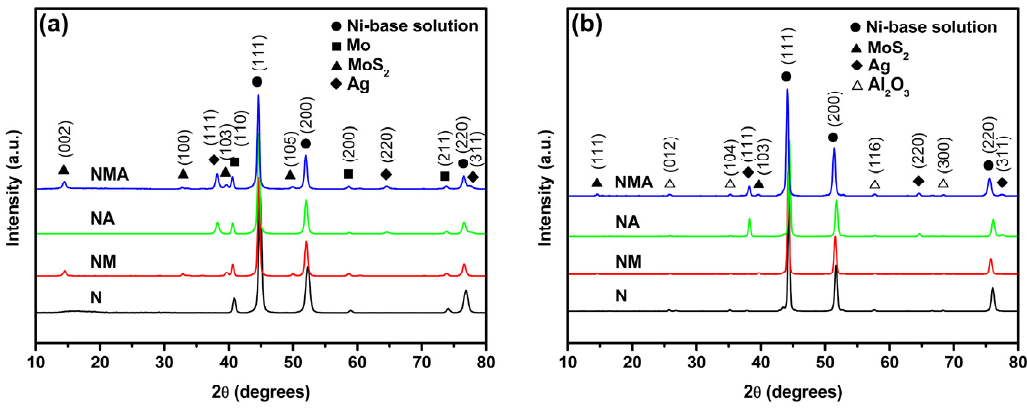
Figure 1. XRD patterns of the ( a ) mixed powders and ( b ) sintered composites.